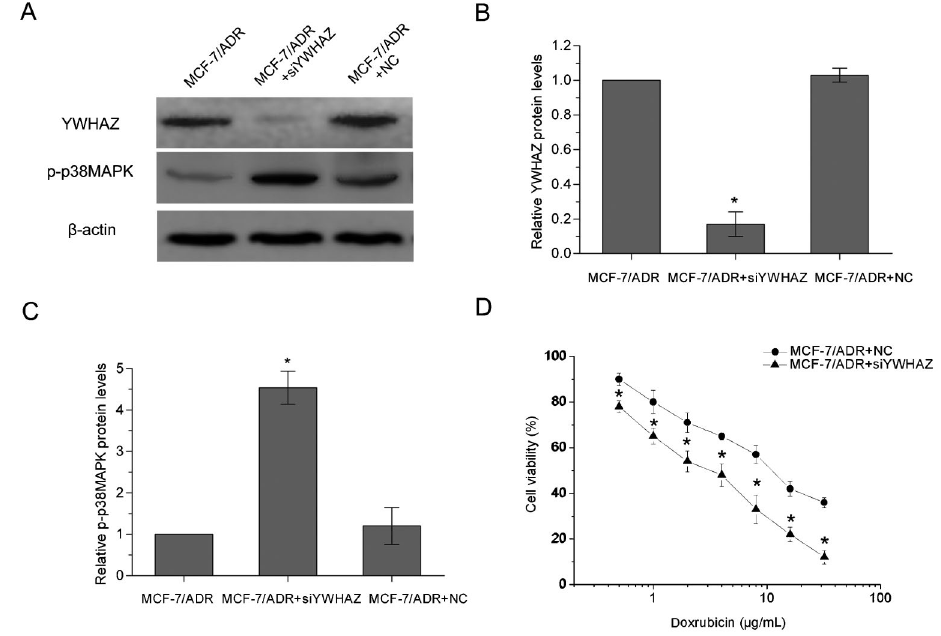
Figure 4. YWHAZ was a key signal molecule in doxorubicin (ADR) resistance by reducing the activation of p38MAPK signal pathway in MCF-7/ADR cells. A , B and C , YWHAZ and p-p38MAPK protein levels in MCF-7/ADR cells transfected with YWHAZ small interfering (si) RNA or a scrambled siRNA (*P , 0.05, Student t -test). D , After 48-h transfection, MCF-7/ADR cells were treated with various doses of doxorubicin. Cell viability was determined using the CCK-8 assay (*P , 0.05, Student t -test). NC: negative